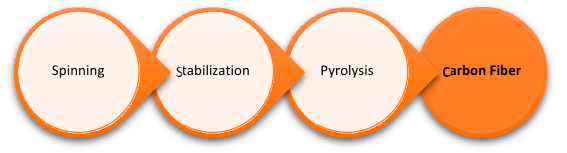
Figure 13. Workflow for the use of lignin as a precursor for carbon fiber.